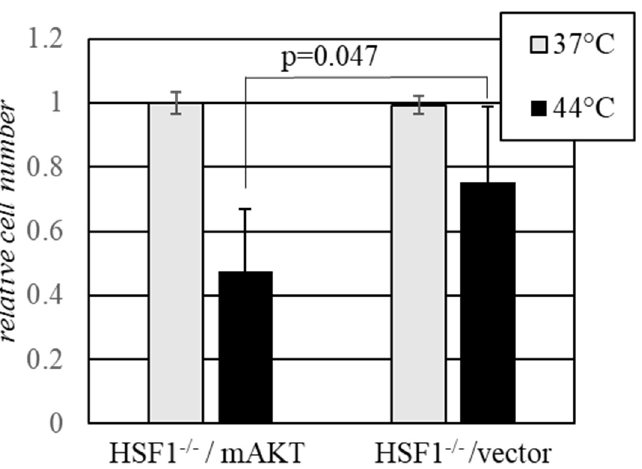
Figure 3. Activated AKT sensitizes to heat shock independently of HSF1. HSF1-deficient MEF (HSF-/-) harboring either mAKT or the corresponding empty vector were treated for 30 min at the indicated temperatures. The remaining cells were scored after 48 hours of recovery under normal growth conditions. The data from triplicate experiments for each cell line are shown normalized to the average values in the respective control (37 ◦ C)